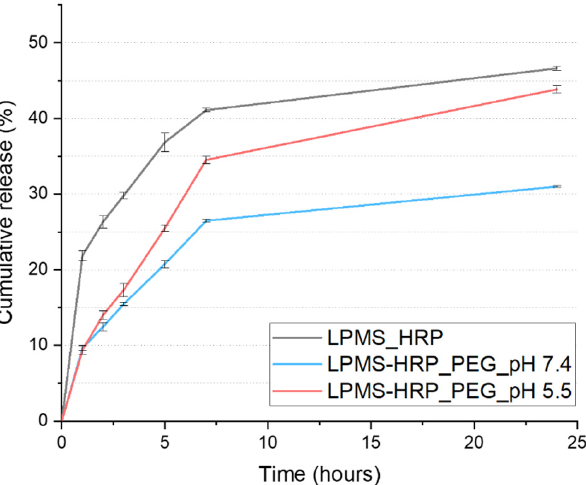
Figure 5. Horseradish peroxidase (HRP) release profiles from LPMS-HRP particles under physiologi- cal conditions (grey), PEG-coated samples at pH 7.4 (light blue) and pH 5.5 (light